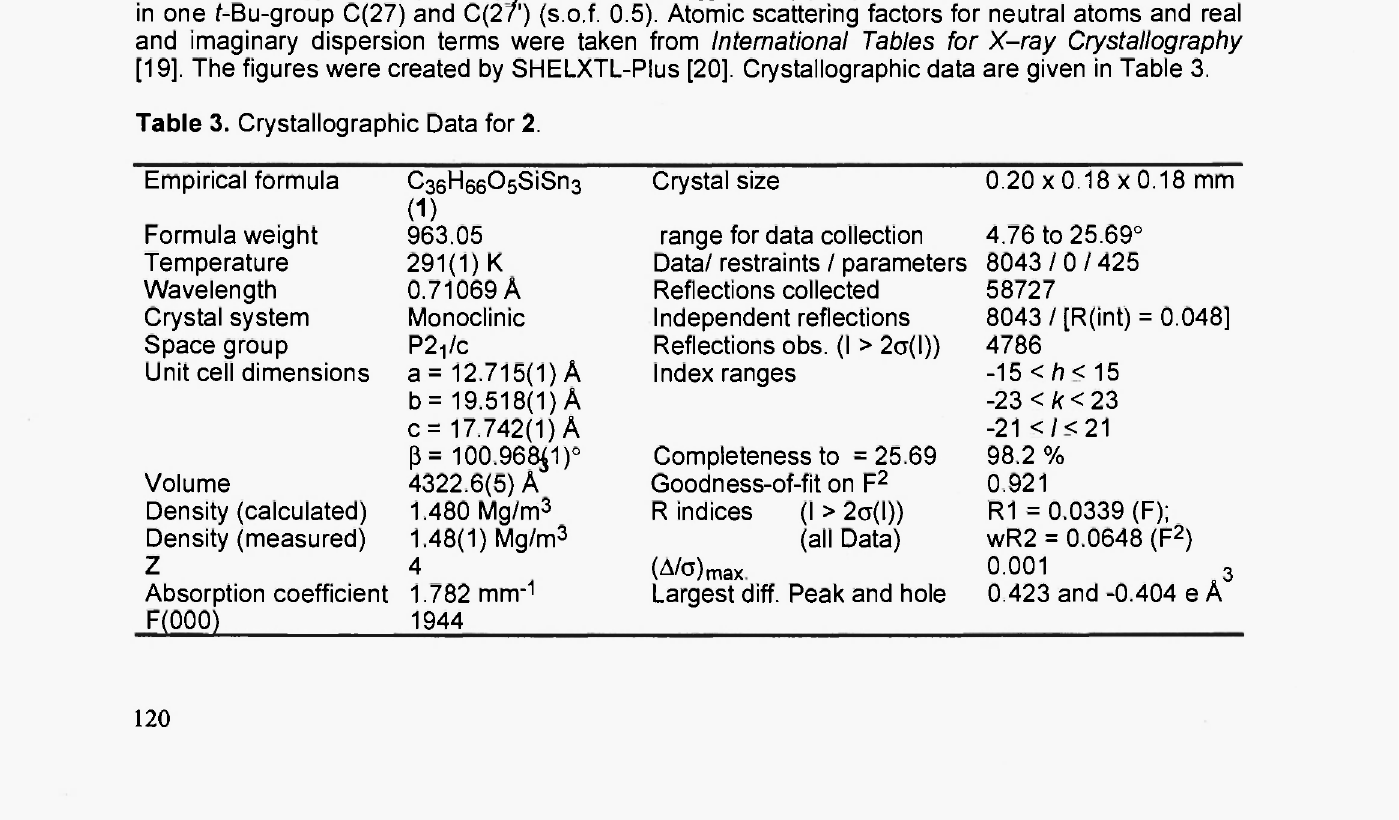
Table 3. Crystallographic Data for